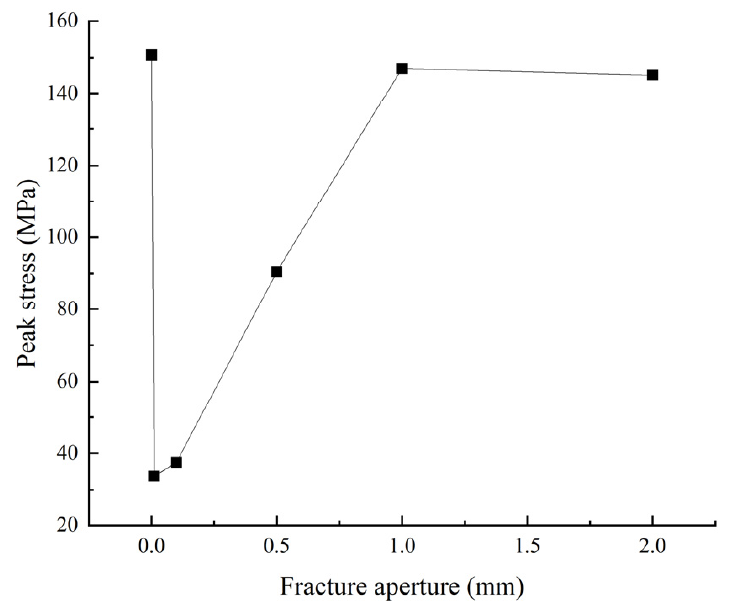
Figure 13. The peak stress is greatly affected when the fracture aperture is extremely small, and the peak stress decreases gradually when the fracture aperture is greater than 2 mm.